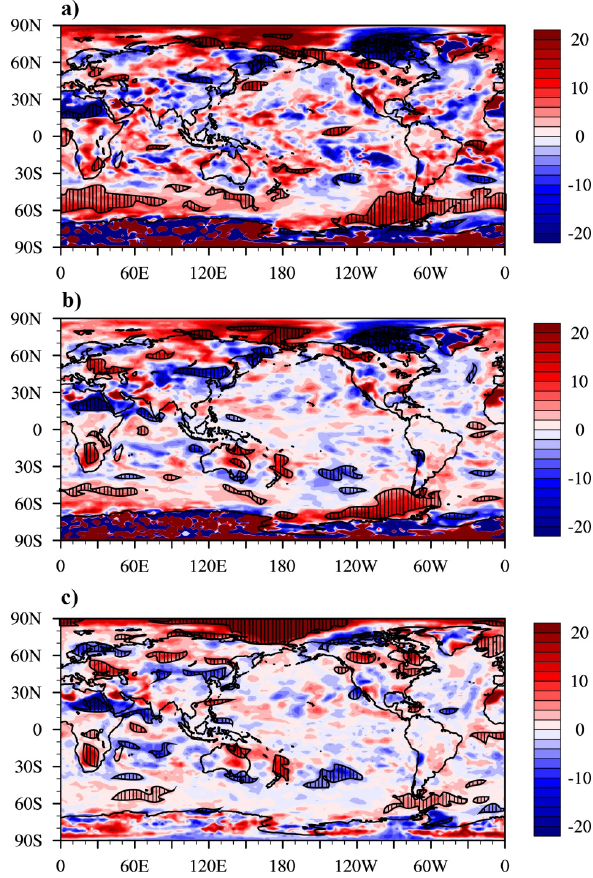
Fig. 2. Model predicted percentage change between the G11 and Default in the 10-yr average grid-mean column ( a) cloud droplet Figure 2. Model predicted percentage change between the G11 and Default in the 10 ‐ year average grid ‐ mean number, ( b) liquid water path, and ( c) shortwave cloud forcing by column a)cloud droplet number, b) liquid water path, and c) shortwave cloud forcing bymarine emissions. Striped marine emissions. Striped areas have 10 or more contiguous model areas have 10 or more contiguous model grids with significant ( p ‐ value of paired t ‐ test < 0.1) differences between grids with significant ( p -value of paired t-test < 0.1) differences be- the G11 and Default simulations. tween the G11 and Default